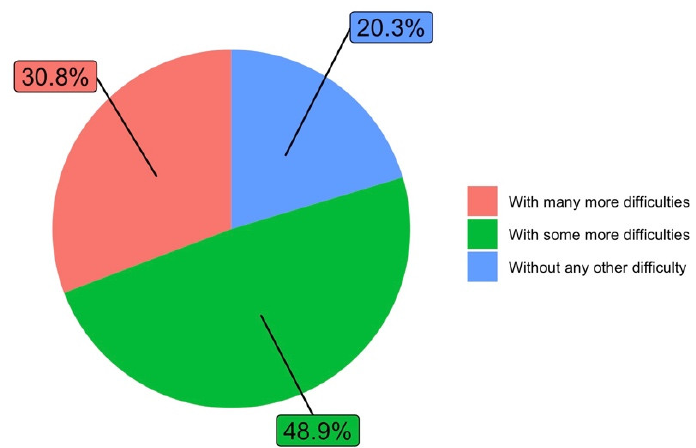
Figure 6. Reconciliation of virtual teaching activity with personal life compared to reconciliation in standard conditions (answers to Q3).